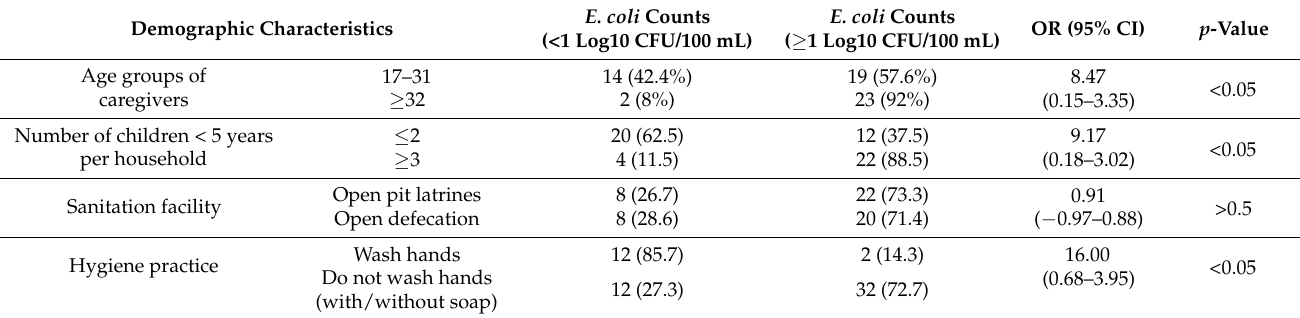
Table 3. Relationship between demographic characteristics, socio-demographic characteristics, and mean concentration of E. coli isolated from treated water stored in regular containers. N =